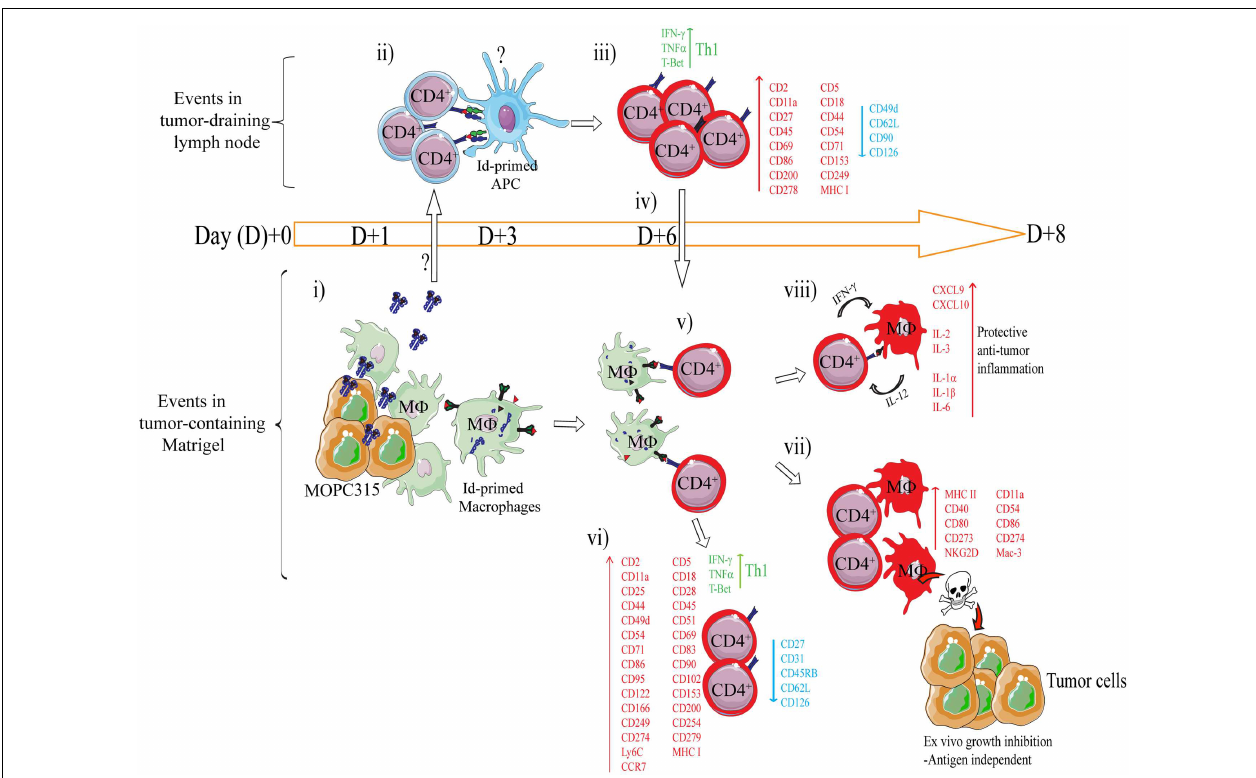
FIGURE 4 | Mechanism of rejection of MHCII NEG myeloma cells by Id-specific CD4 + T cells. The following events are based on experiments where Id-secreting MOPC315 suspended in liquid Matrigel was injected subcutaneously inTCR-transgenic mice. (i–viii). (i) At the incipient tumor site, macrophages [CD11b + , CD11c − , CD80/CD86 + MHC II LO , F4/80 + ] start to infiltrate the tumor/Matrigel from day + 1.Tumor-infiltrating macrophages become Id-primed by extracellular myeloma protein by the conventional MHC II presentation pathway (65). (ii) Extracellular Id + myeloma protein (or possibly Id-primed tumor APCs) drain to lymph nodes where